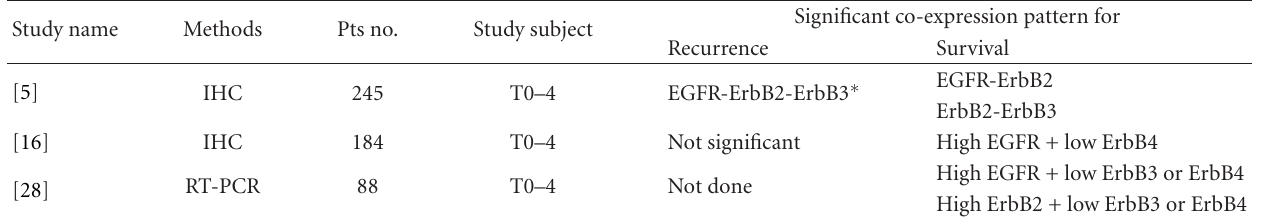
Table 4: Co-expression of ErbB receptor family as a marker for bladder cancer prognosis.